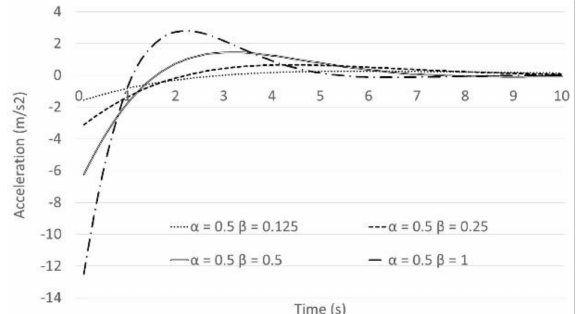
Figure 6. The following vehicle’s acceleration behaviour: Representation of the cutting off behaviour speed ( α is